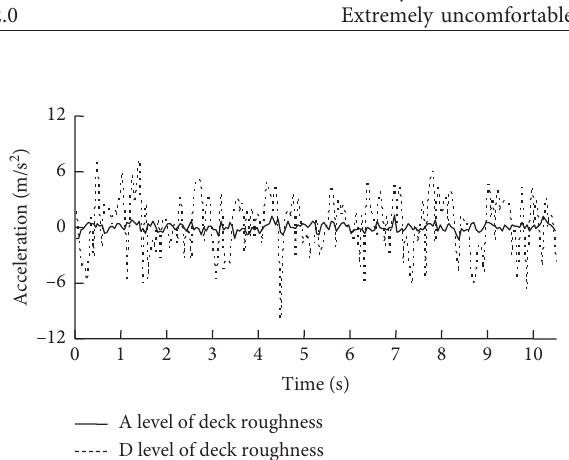
Figure 8: The time-history curves of vertical vibration accelera- tions of the vehicle body.